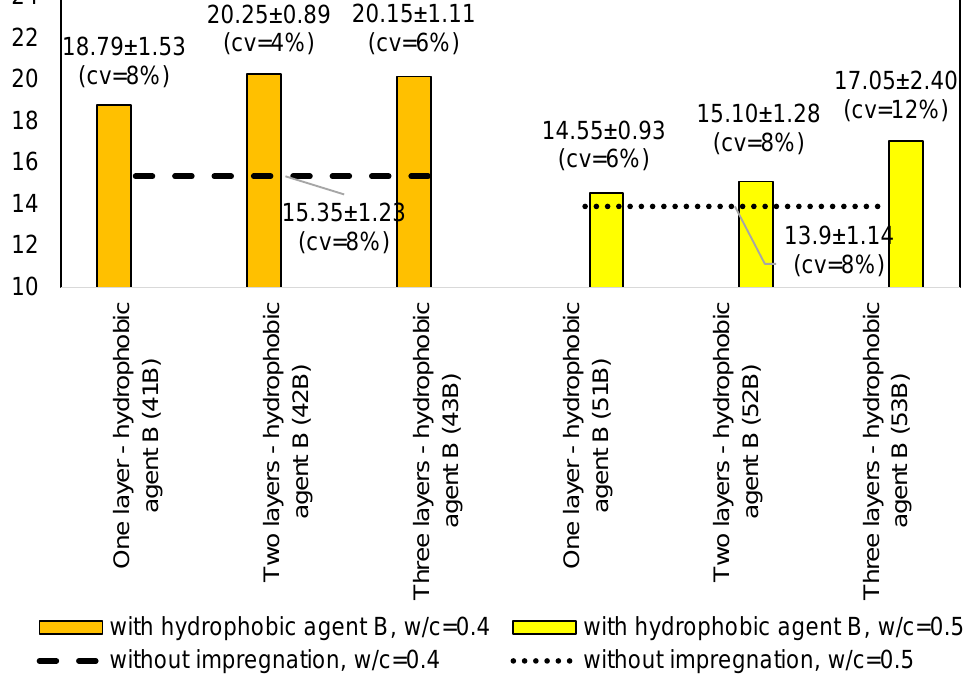
with hydrophobic agent B, w/c=0.4 with hydrophobic agent B, w/c=0.5 without impregnation, w/c=0.4 without impregnation, w/c=0.5 Figure 6. Rebound number comparison for samples with different w/c and impregnation using hydrophobic agent B.